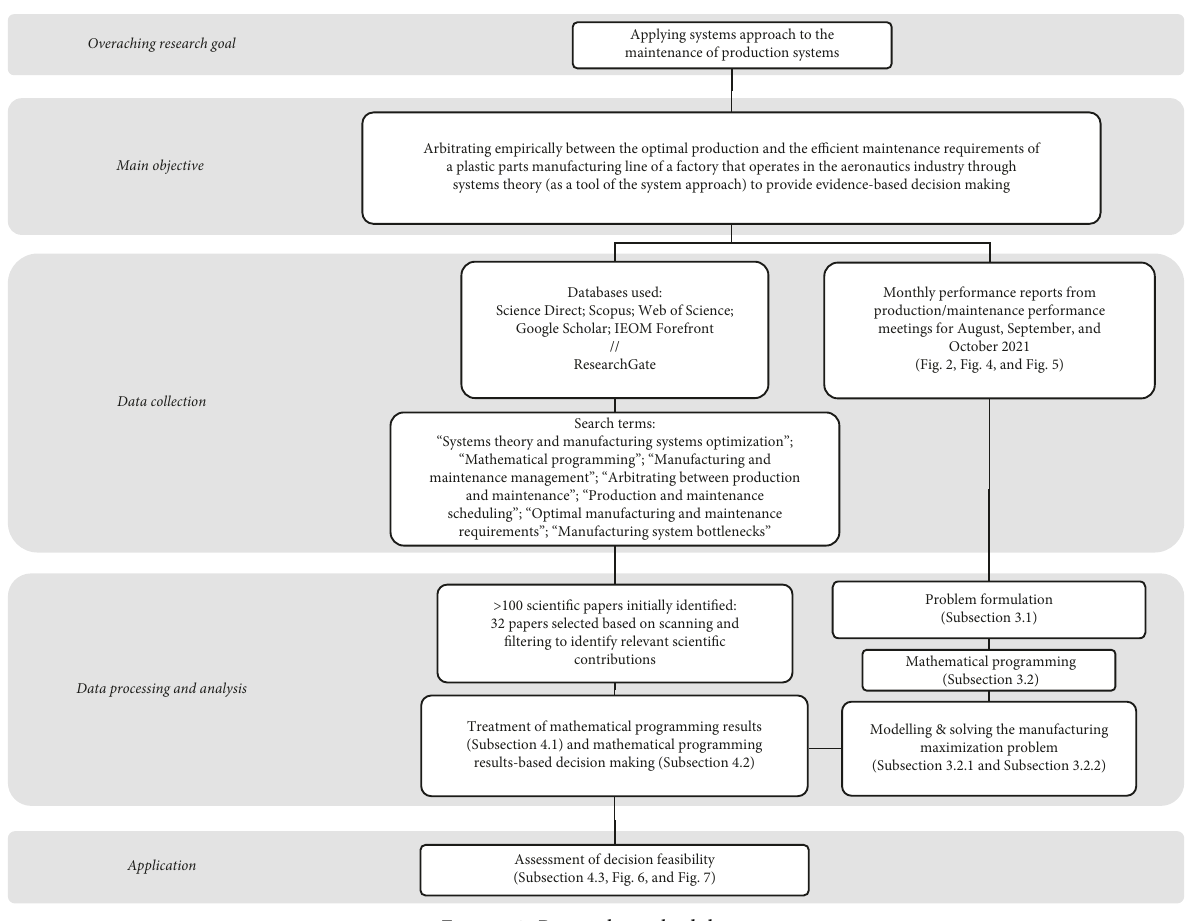
Figure 1: Research